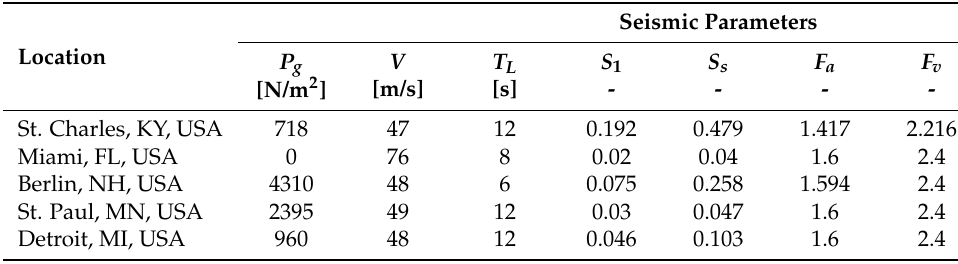
Table 7. Loading parameters of different frame